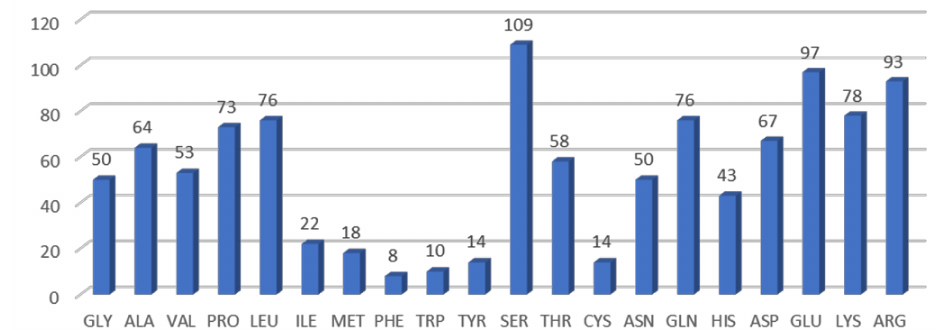
Figure 1. Occurrence of residue types on the protein solvent accessible surface. Surface includes residues having RSA ≥ 20% ([30], see text for details); figures over the columns indicate the absolute number of each residue type on the protein surface, labelled following the amino acids three letters code.